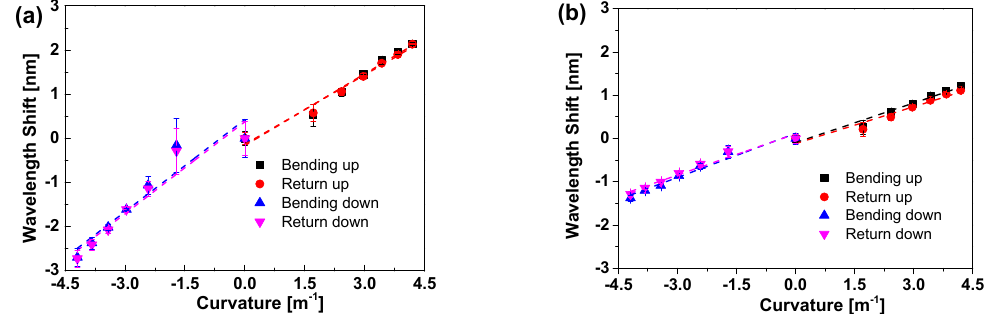
Figure 3. Bend response of POFBG ( a ) and SOFBG ( b ) on the upper surface of brass beam vs. the curvature, when the beam is bent upwards or downwards. Table 2. The linear fitting results of POFBG and SOFBG response to the bend. FBG